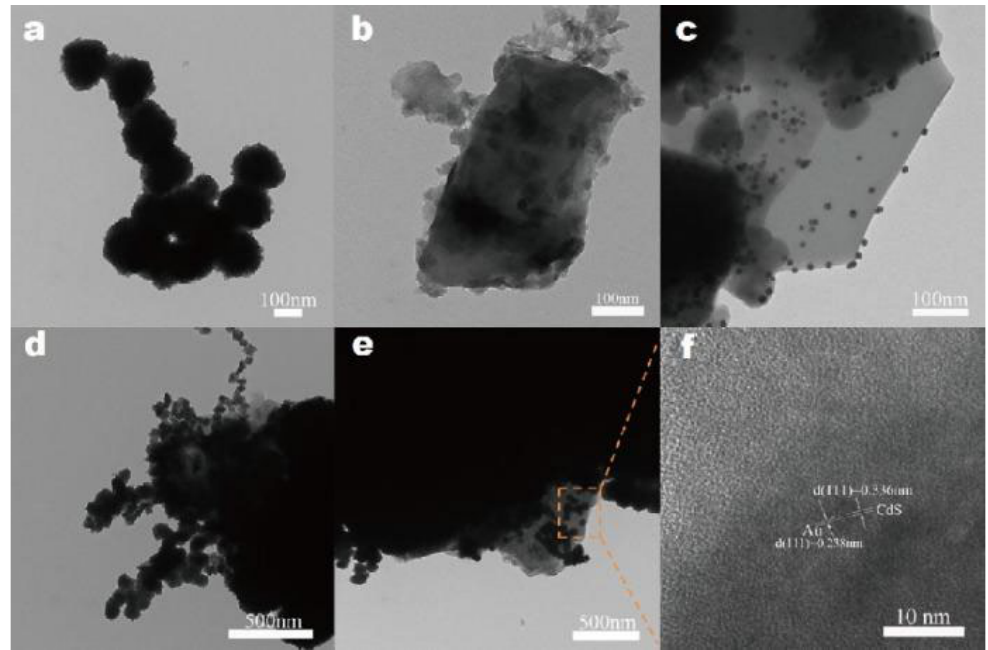
Figure 7. TEM images of ( a ) CdS, ( b ) MXene, ( c ) MXene@Au, ( d ) MXene@CdS, ( e ) MXene@Au@CdS and HRTEM image of ( f ) MXene@Au@CdS [67].